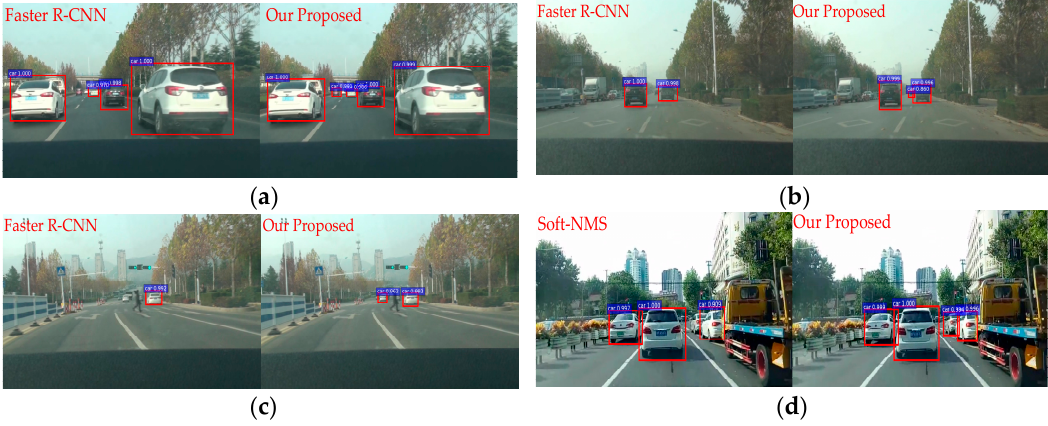
Figure 13. Detection results of preceding vehicles by Faster R-CNN and our proposed optimized Faster R-CNN: ( a ) speed stage 0–20 km/h; ( b ) speed stage 20–60 km/h; ( c ) speed stage 60–120 km/h; ( d ) optimized Faster R-CNN; linear weighting was chosen and Q = 4.